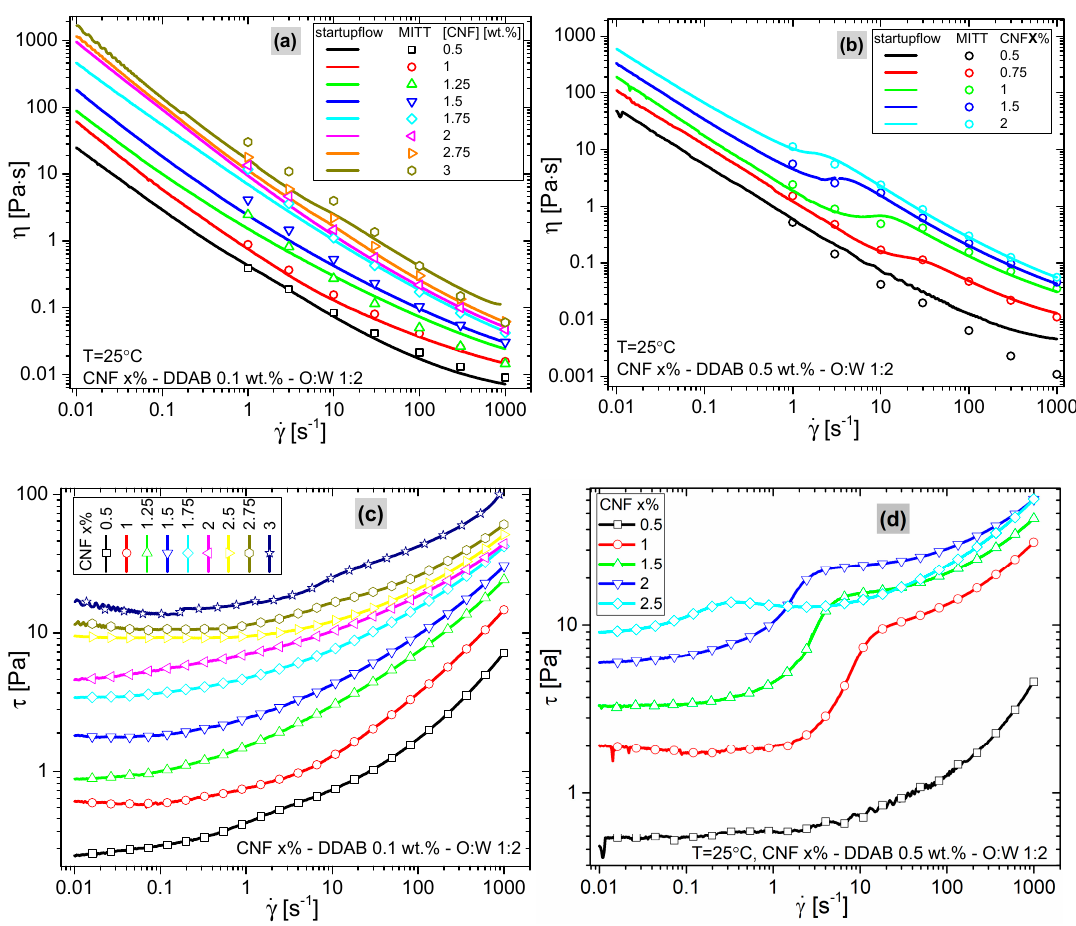
Figure 8. Startup flows in comparison with viscosity functions determined with the miTT protocol. Viscosity functions of ( a ) the 0.1 wt.% DDAB series and ( b ) the 0.5 wt.% DDAB series. Shear stress functions of ( c ) the 0.1 wt.% DDAB series and ( d ) the 0.5 wt.% DDAB series.